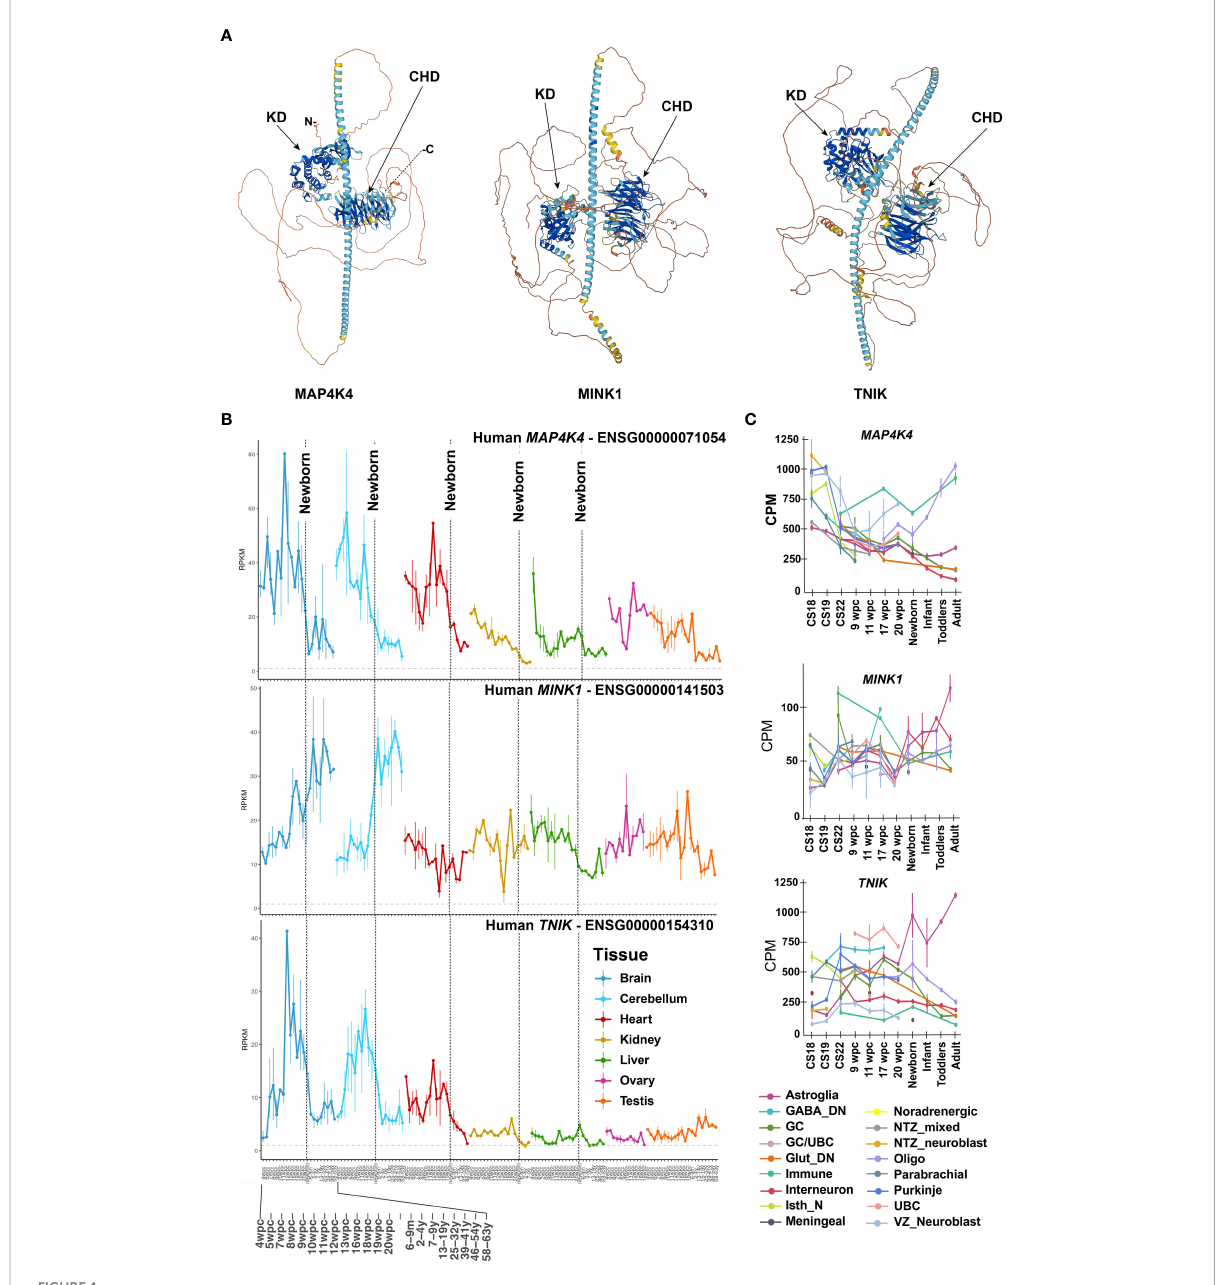
FIGURE 1 Protein structure and differential expression of MAP4K4 , MINK and TNIK across tissues and developmental stages. (A) AlphaFold protein structures of MAP4K4 (UniProt: E7ENQ1), MINK1 (UniProt: Q8N4C8) and TNIK (UniProt: Q9UKE5) (11, 12). CHD, citron homology domain, KD, kinase domain. (B) MAP4K4 , MINK1 and TNIK single nucleus RNA sequencing expression pro fi les across organs and developmental stages (13). The X-axis depicts developmental stage before and age after birth. The vertical dotted lines indicate birth. The Y-axis are reads per kilobase of exon model per million mapped reads (RPKM). (C) Single nucleus mRNA expression analysis of MAP4K4 , MINK1 and TNIK across human developmental stages of the human cerebellum (14). CPM, Counts per million; GABA, Gamma-aminobutyric acid, DN, Dentate nucleus; GC, Granule cells; UBC, Unipolar brush cells; Glut_DN, Glutamatergic deep nuclei neurons; Isth_N, Isthmic nuclei neurons; NTZ, Nuclear transitory zone; VZ, Ventricular